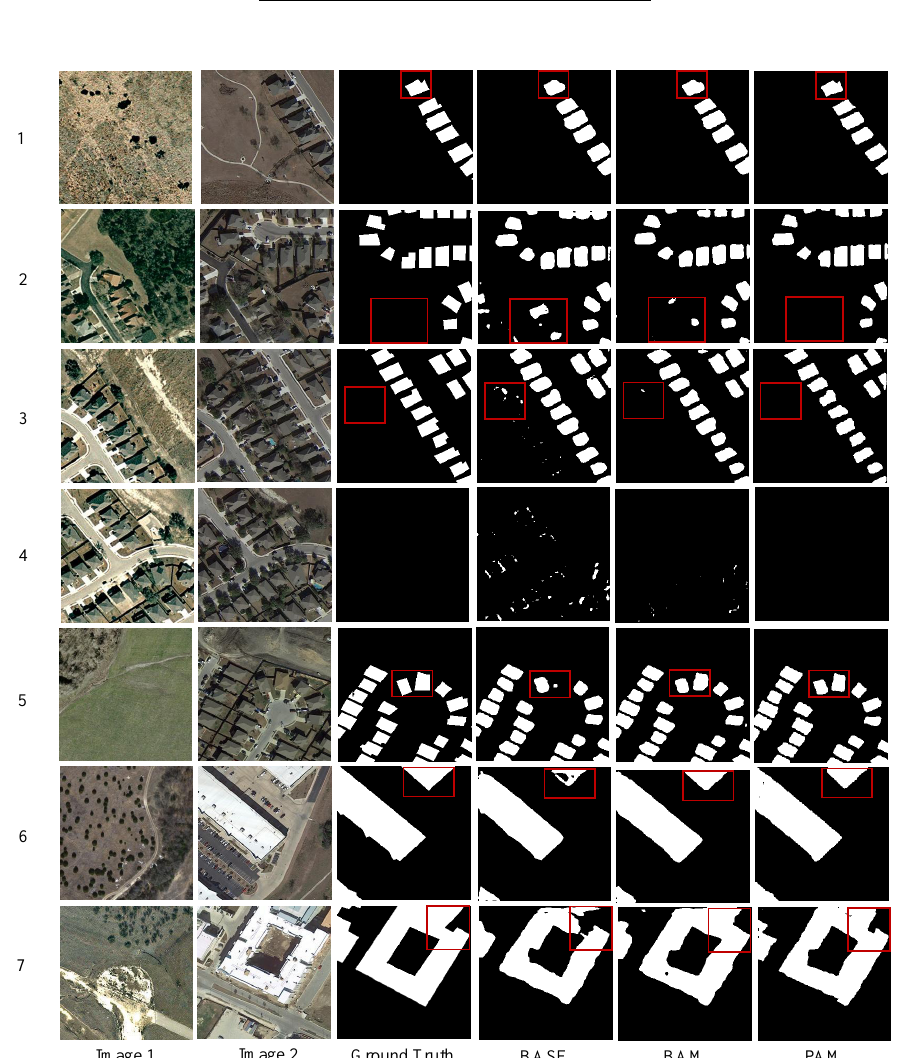
Figure 6. Change detection examples of our ablation experiments on the LEVIR-CD test set. The red boxes are drawn to highlight the advantages of our attention modules. Our BAM and PAM models obtain finer details (rows 1 and 7), with a lower false alarm rate (rows 2, 3 and 4), and higher recall (row 5, 6 and